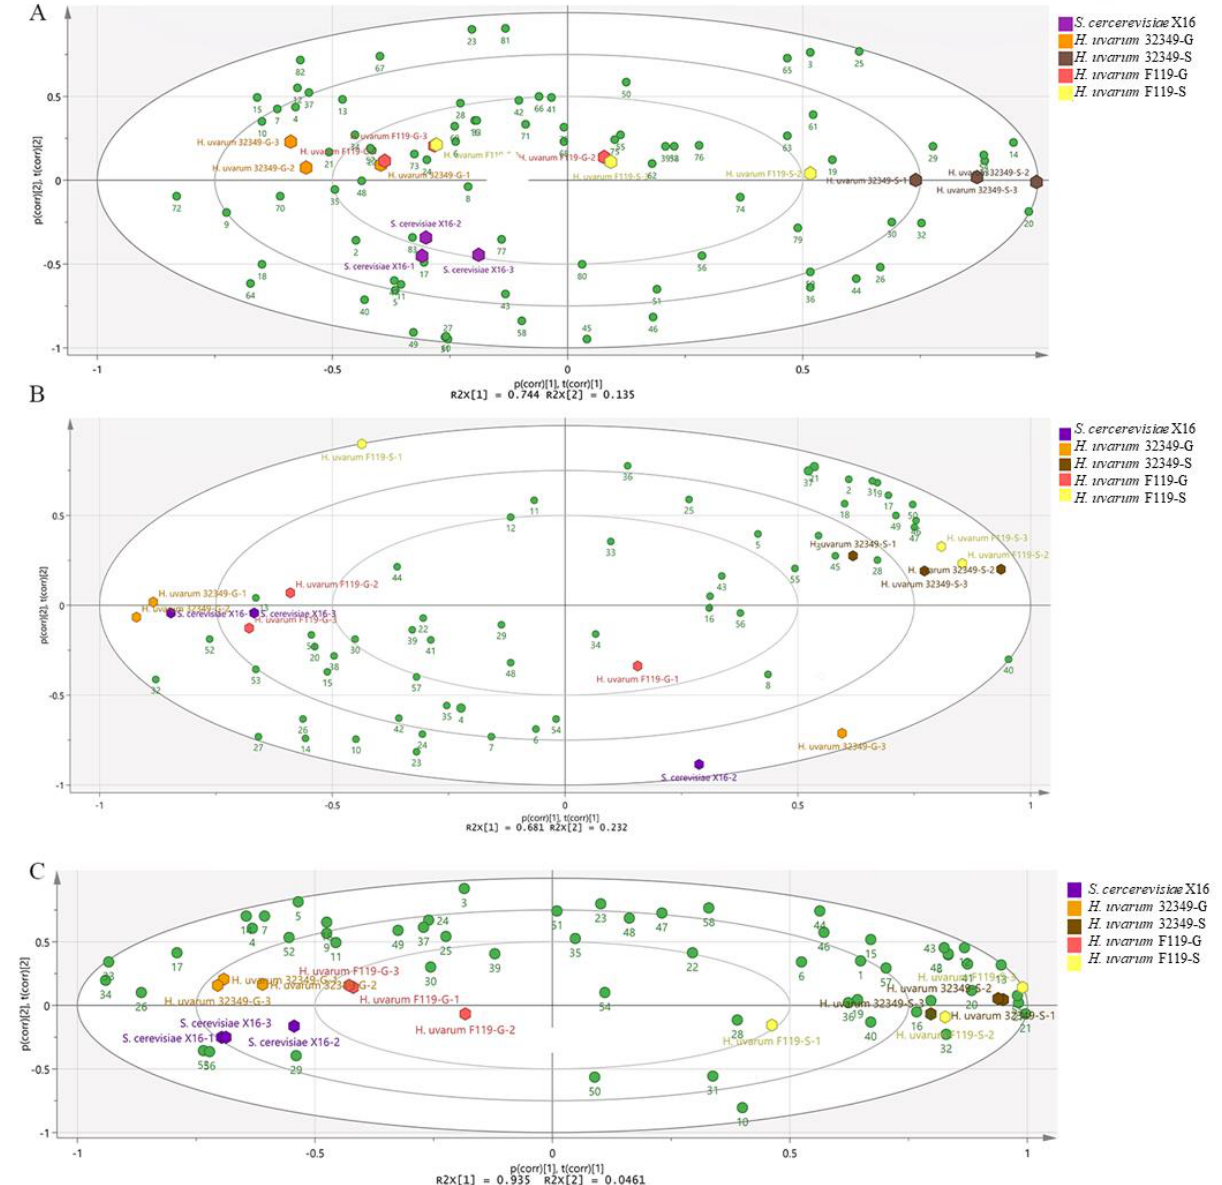
Figure 3. PCA of the wine samples ’ volatile compounds in different fermentations. ( A ) R. rox- burghii wine; ( B ) blueberry wine; ( C ) plum